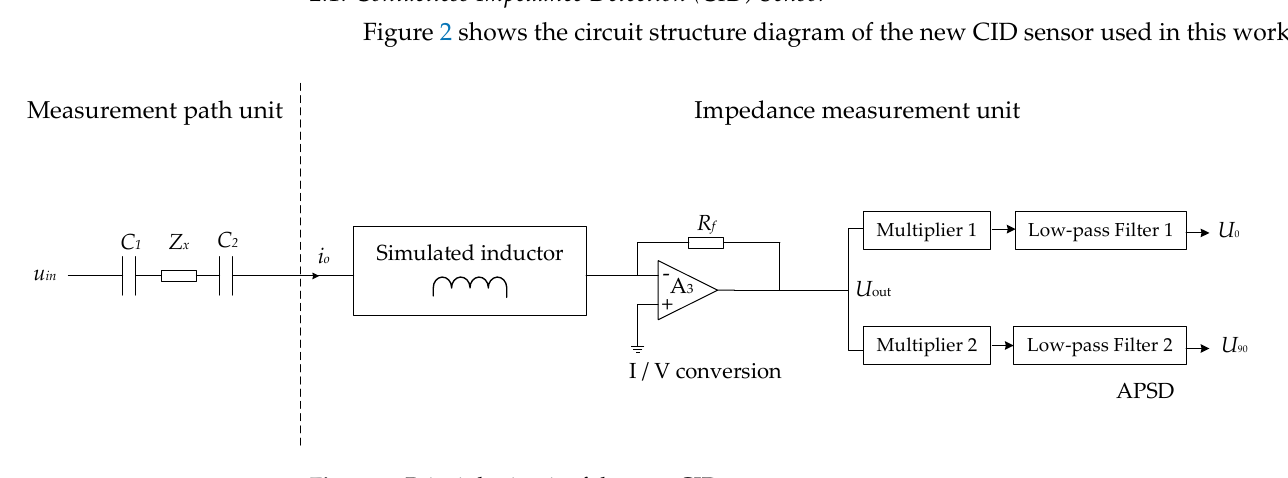
Figure 2. Principle circuit of the new CID sensor.